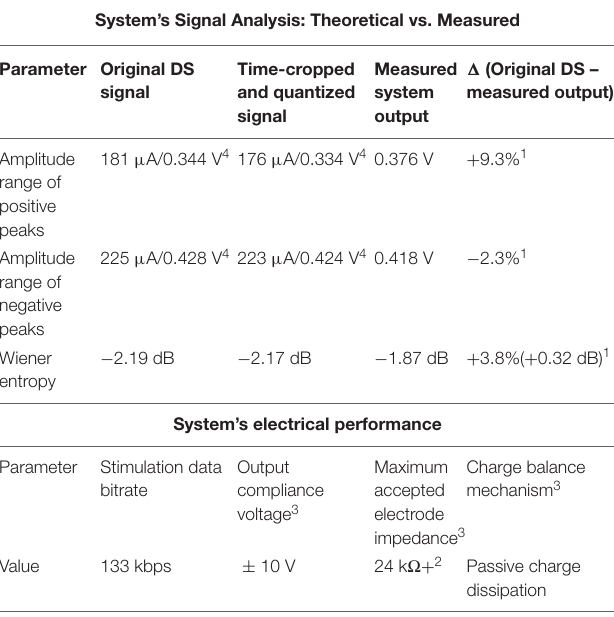
TABLE 1 | Performance of the biomimetic stimulator prototype. System’s Signal Analysis: Theoretical vs.